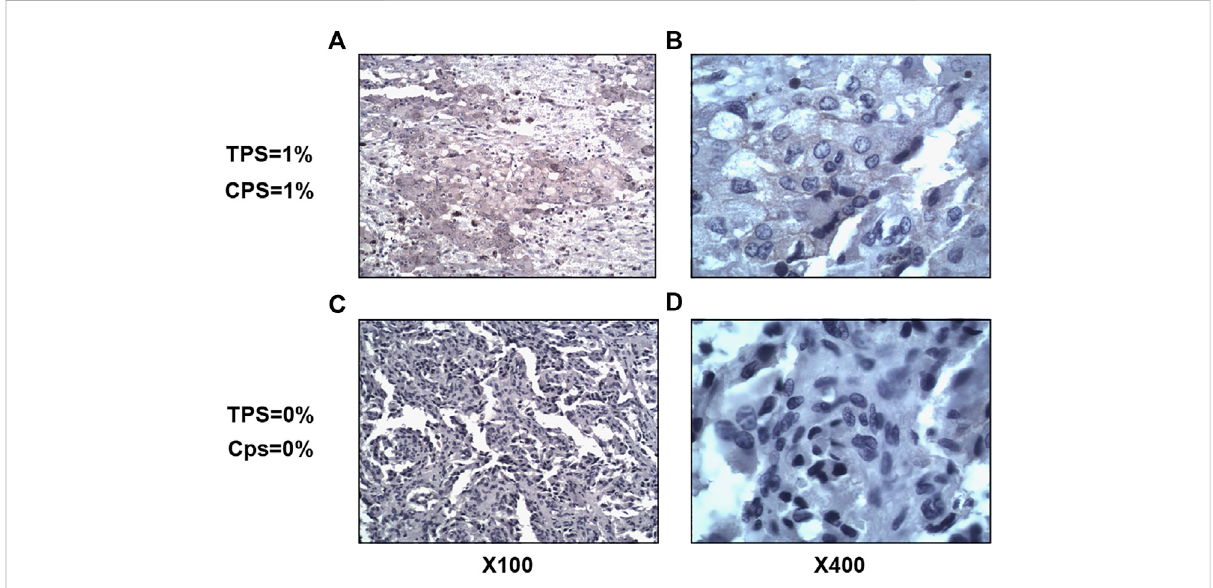
FIGURE 1 Immunohistochemical staining of PD-L. Left images × 100, right images × 400. (A,B) , TPS = 1% and CPS = 1%; (C,D) , TPS = 0% and CPS =